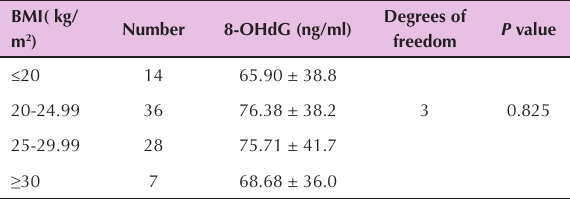
Table 7. Comparison of mean serum 8-OHdG levels in individuals with different BMI